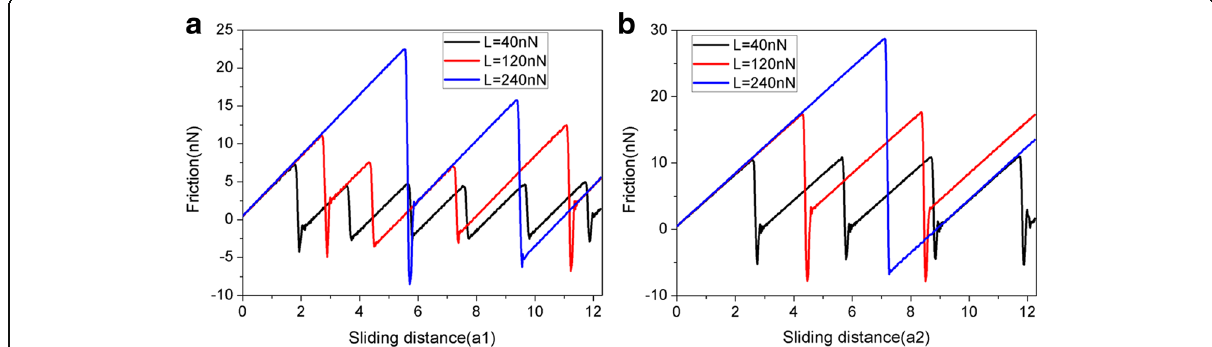
Fig. 7 The friction force of the 5.8-nm square flake sliding on the ( a ) Au(001) and ( b ) Au(110) surfaces as a function of sliding distance at different normal loads. Here, a1 (= 4.08 Å) is the lattice spacing of Au(001) along the sliding direction and a2 (= 4.08 Å) is lattice spacing of Au(110) along the sliding